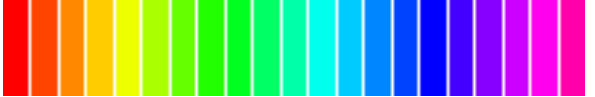
Figure 2. Temporal color palette: 21 acquisitions, from January 2017 (red) to December 2017